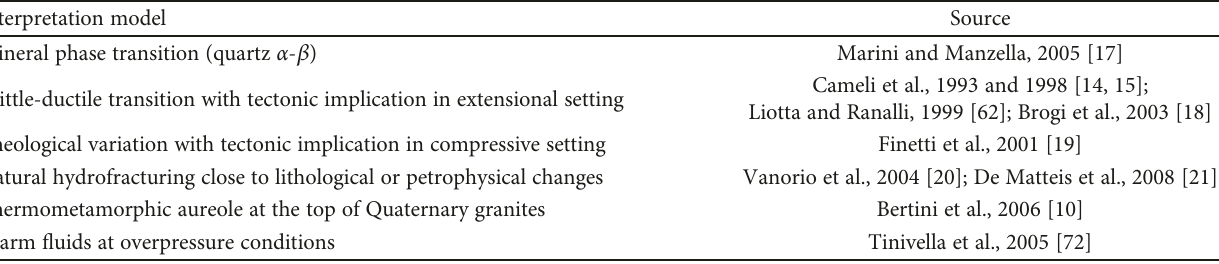
Figure 5: Simpli fi ed geological map of the study area (modi fi ed from http://www502.regione.toscana.it/geoscopio/geologia.html) . The stratigraphic units have been merged to represent the geological units modelled in the present work. The wells used to constrain the geological model are shown. The dotted black line represents the segment of the CROP-18A seismic re fl ection line (Figure 6(b)) used in synthetic seismic re fl ection modelling (note in grey the continuation of the CROP-18A). Table 1: Interpretation models proposed in the literature to explain the evidence of the K-horizon in seismic pro fi les in the Larderello geothermal system. The corresponding references are